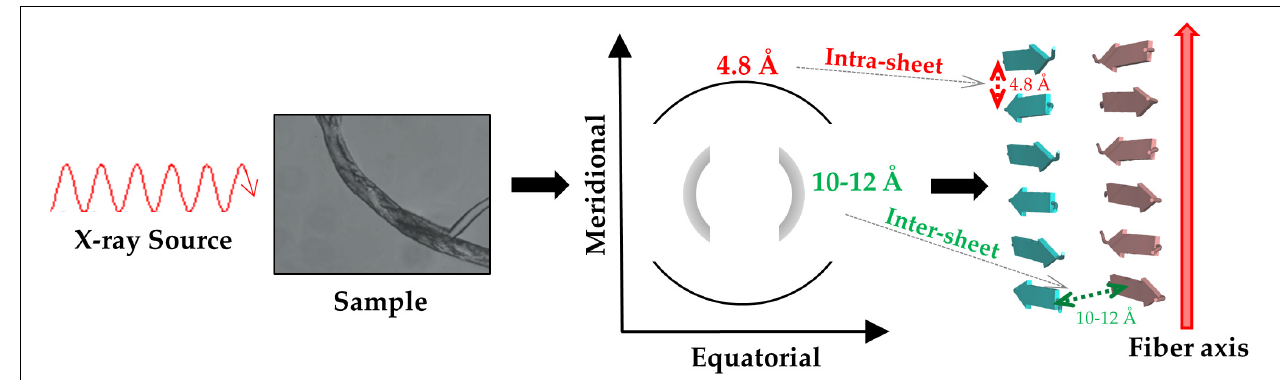
FIGURE 1 | Schematic representation of the diffraction pattern and of the structure of a typical cross- β assembly.